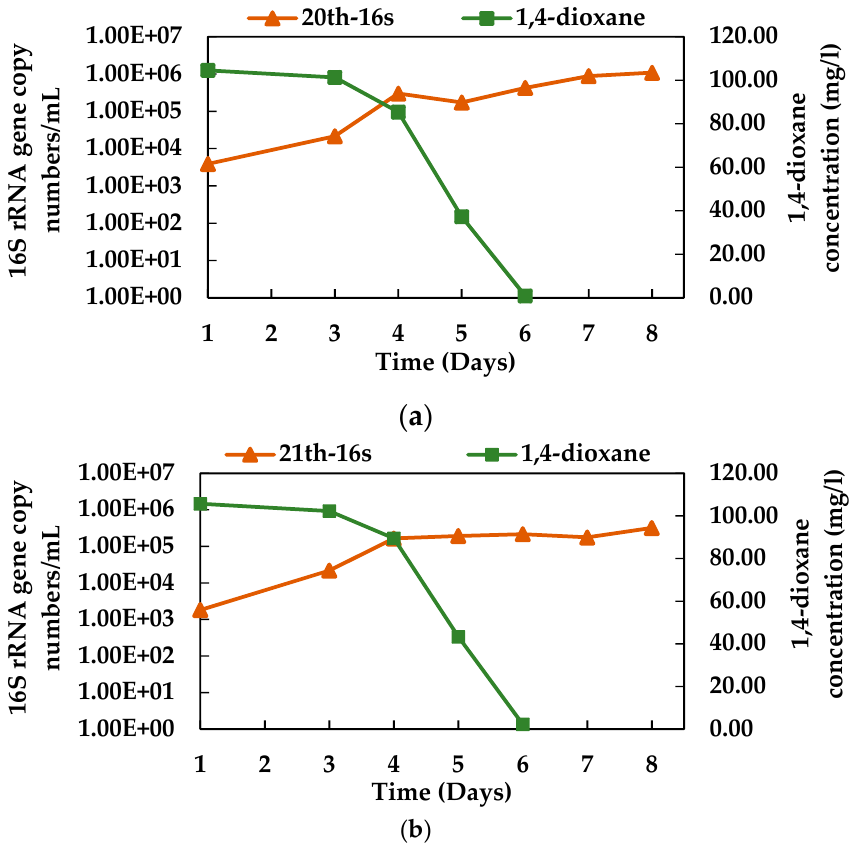
Figure 5. Growth of the enriched microbial consortia N112 with the degradation of 1,4-dioxane at different generations, ( a ) 20th generation and ( b ) 21st generation. Here, the rectangles indicate 1,4-dioxane concentrations and the triangles represent the overall growth of consortium N112, using 16S rRNA gene copy numbers/mL.